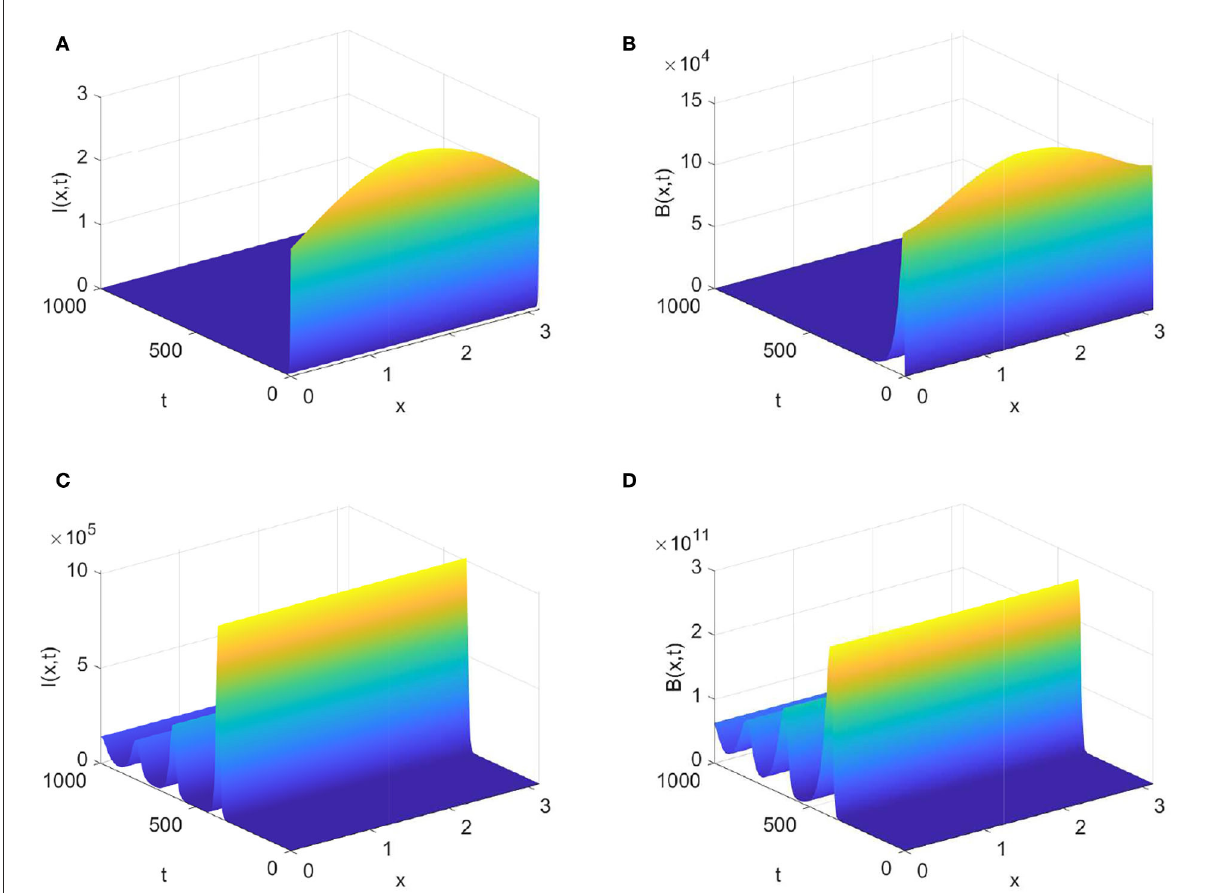
FIGURE2 Evolution of infected animals and FMD virus with parameters in Table 1. (A,B) with R 0 ≈ 0.8381 < 1. (C,D) with R 0 ≈ 4.1778 > 1.